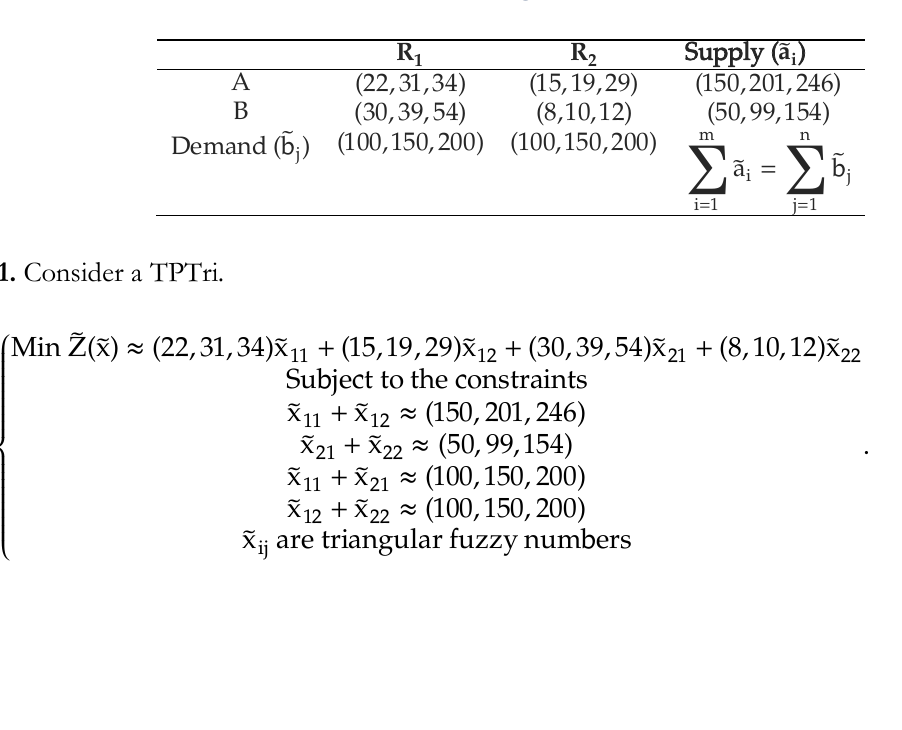
Table 1. (TPTri) in triangular balanced